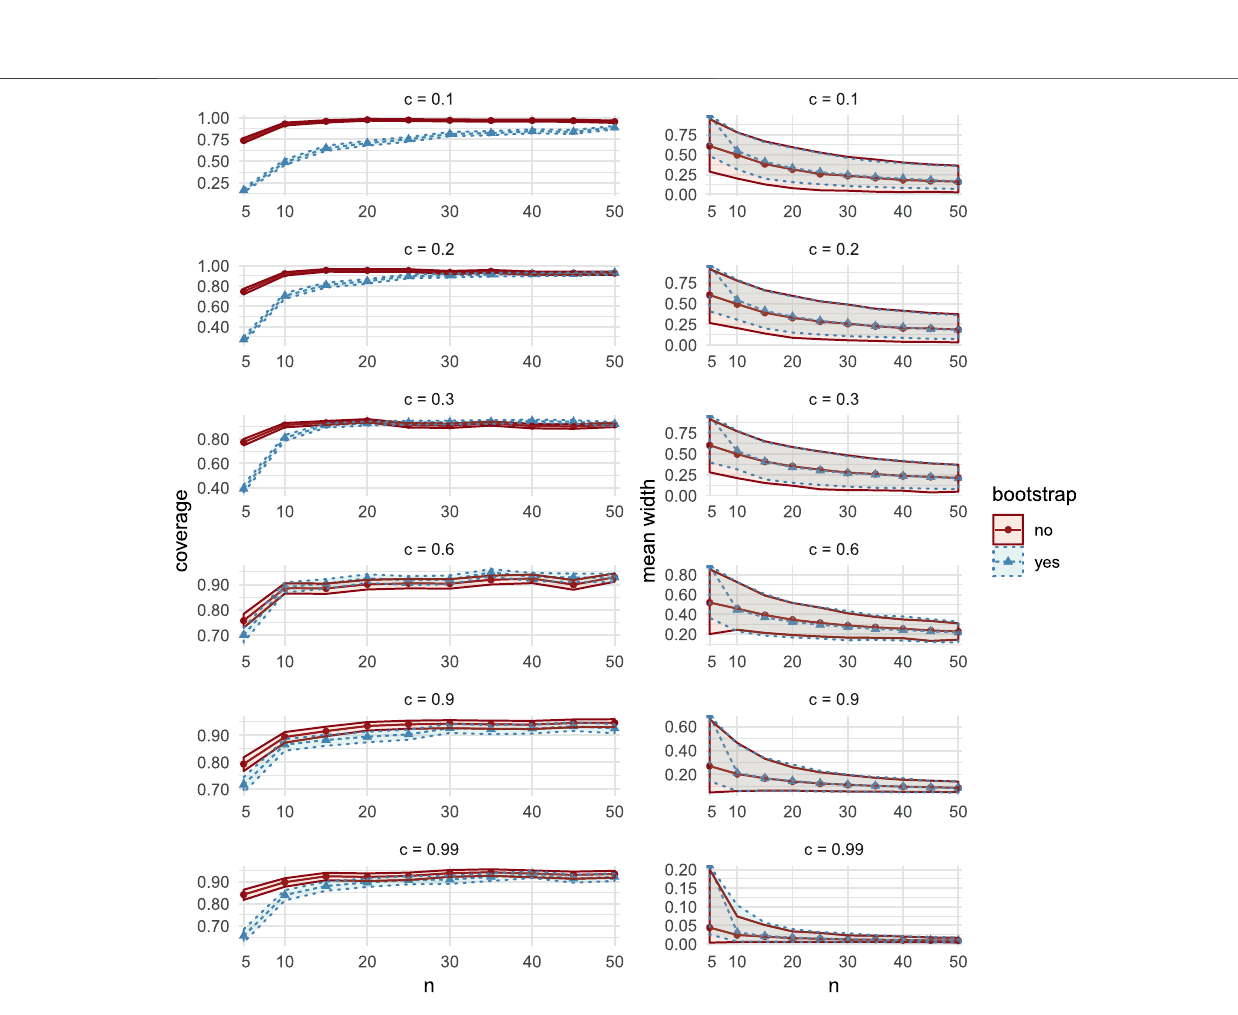
FIGURE 3 | Comparisons of coverage (left column) and mean width (right column) , between the bootstrap CIs (dashed lines with triangular markers) and the asymptotic CIs (solid lines with circular markers) in MC Study C. Rows represent correlations c, increasing from 0.1 on the top row to 0.99 on the bottom row. The horizontal axes display the sample sizes n (cid:2) 5 , 10 , ... , 50.